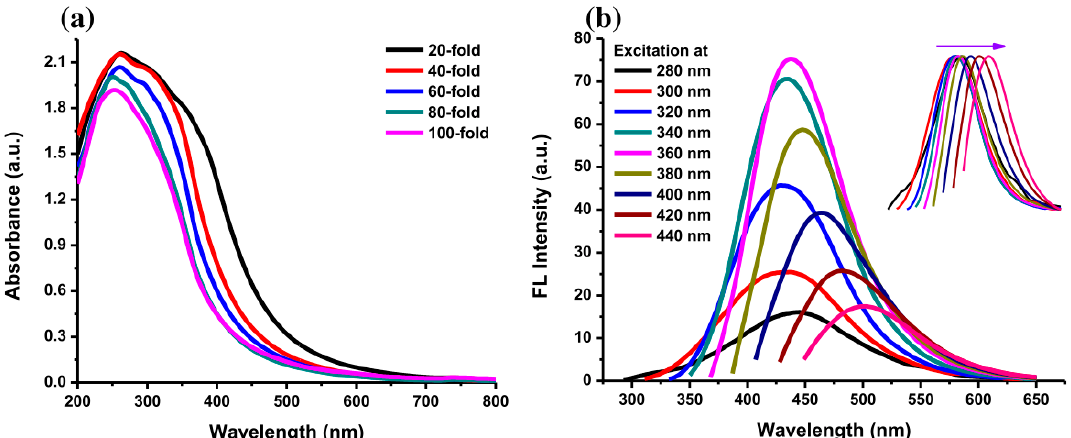
Figure 7. ( a ) UV-Vis absorption spectra of AC-NCDs with various dilution factors and ( b ) fluorescence emission spectra of AC-NCDs at excitation wavelengths of 280–440 nm with 20 nm increment (Inset: normalized fluorescence emission